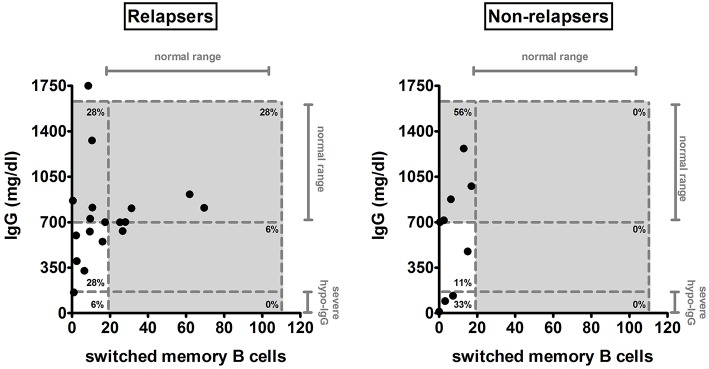
IgG and switched memory B-cell levels at last follow-up in relapsing and non-relapsing patients after anti-CD20 treatment. The amount of serum IgG and of switched memory B cells was compared between relapsing (n = 18) and non-relapsing (n = 9) anti-CD20-treated patients at last follow-up. Each plot represents a different patient. Gray areas and dashed lines represent the age-related normal range between the 5th and 95th percentiles indicated in Piatosa et al. (15) for the different B-cell subsets and by the diagnostic laboratory of our Institution for immunoglobulins. Levels of severe hypogammaglobulinemia (severe hypo-IgG) are also indicated.